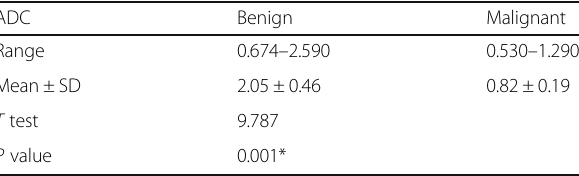
Table 4 ADC range in benign and malignant lesions in our study ADC Benign Malignant Range 0.674 – 2.590 0.530 – 1.290 Mean ± SD 2.05 ± 0.46 0.82 ± 0.19 9.787